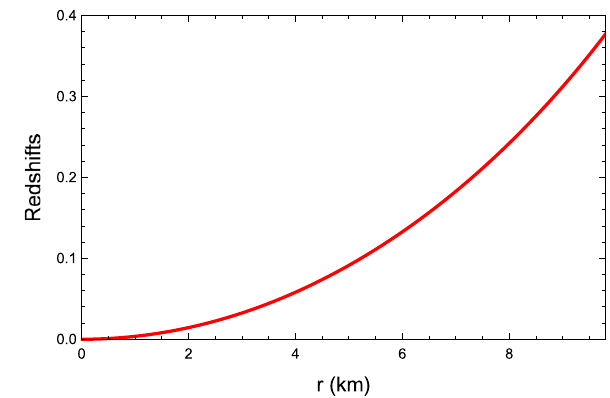
Fig. 11 Variation of mass function and the compactness with radial coordinate r is increasing in nature